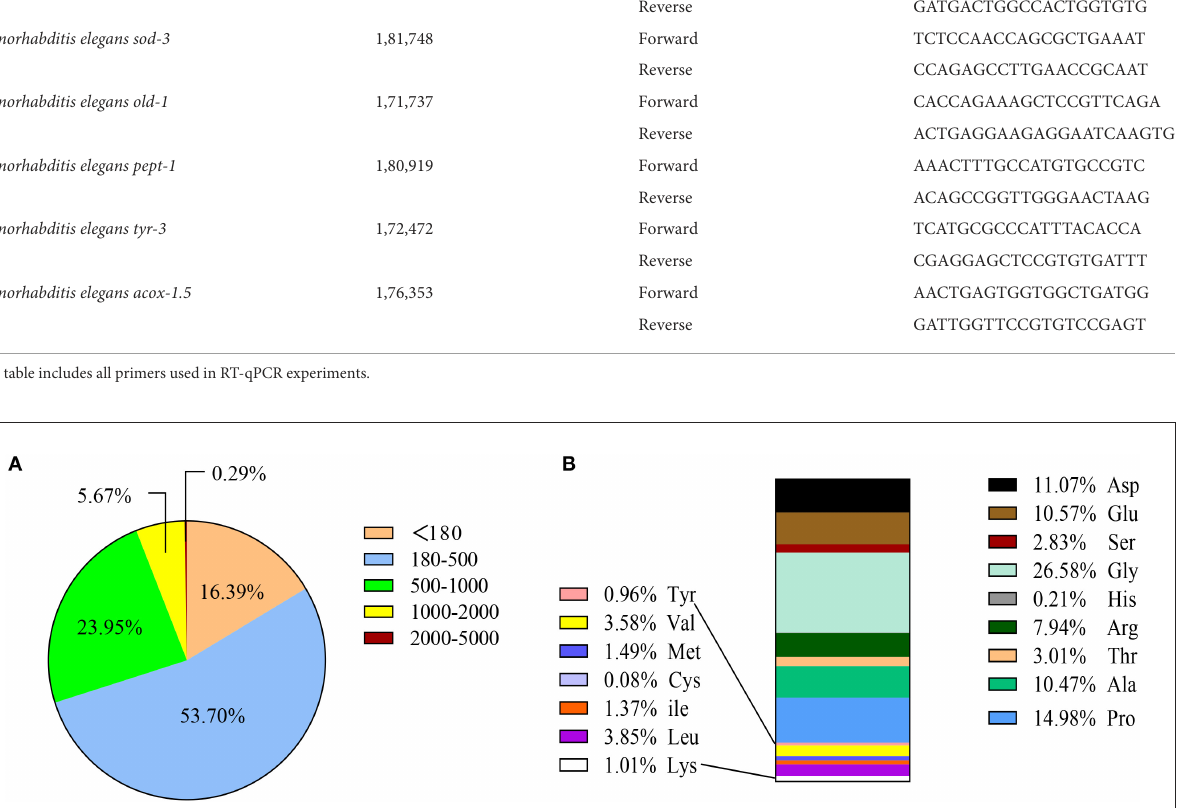
FIGURE1 Amino acid composition and MW distribution of SCPs. (A) MW distribution of SCPs. (B) Amino acid compositions of SCPs.